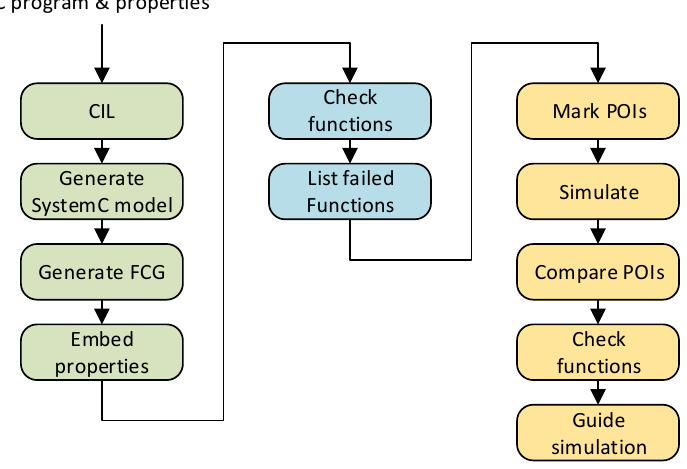
Figure 10. Illustration of the flow executed by Verifyr